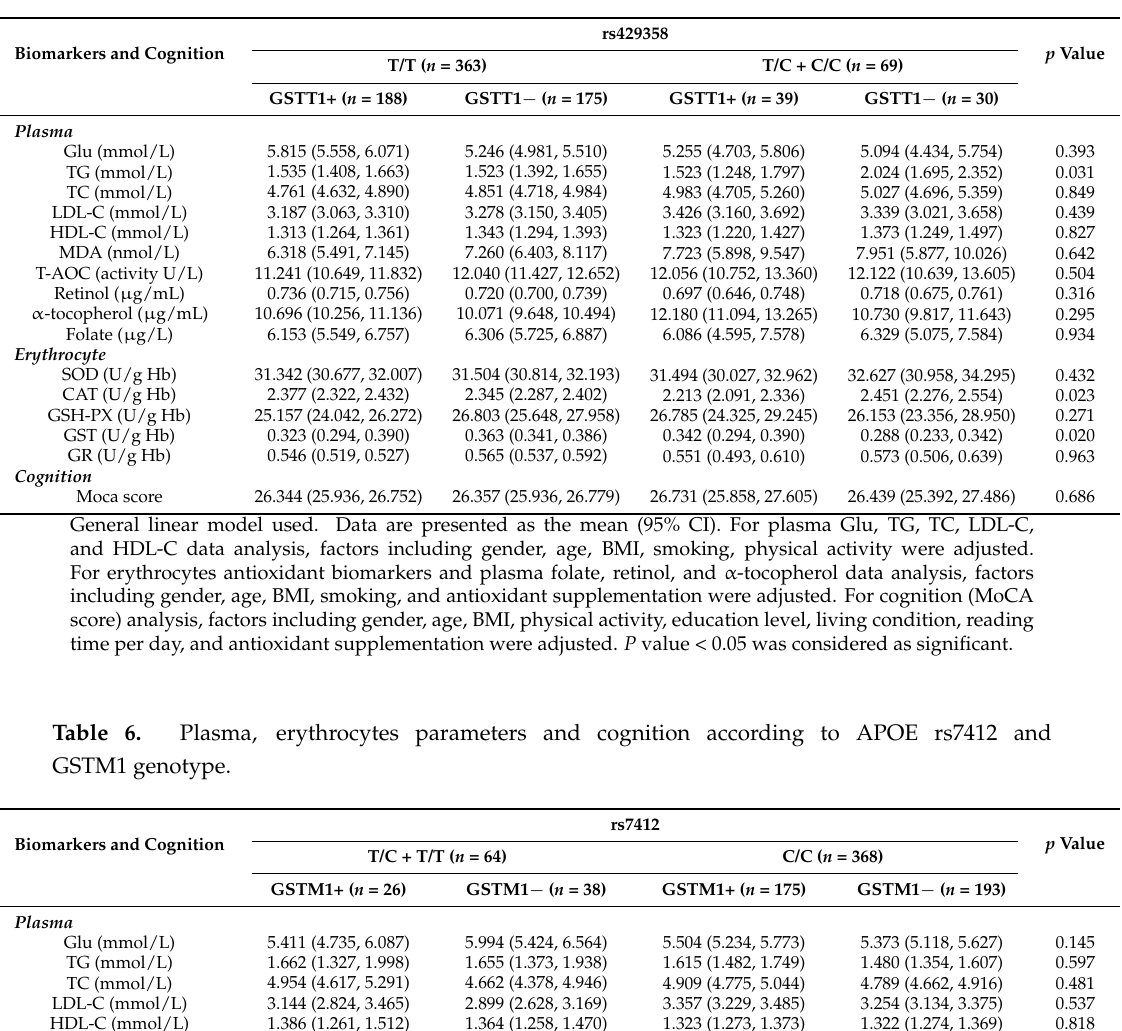
Plasma, erythrocytes parameters and cognition according to APOE rs429358 and GSTT1 genotype.